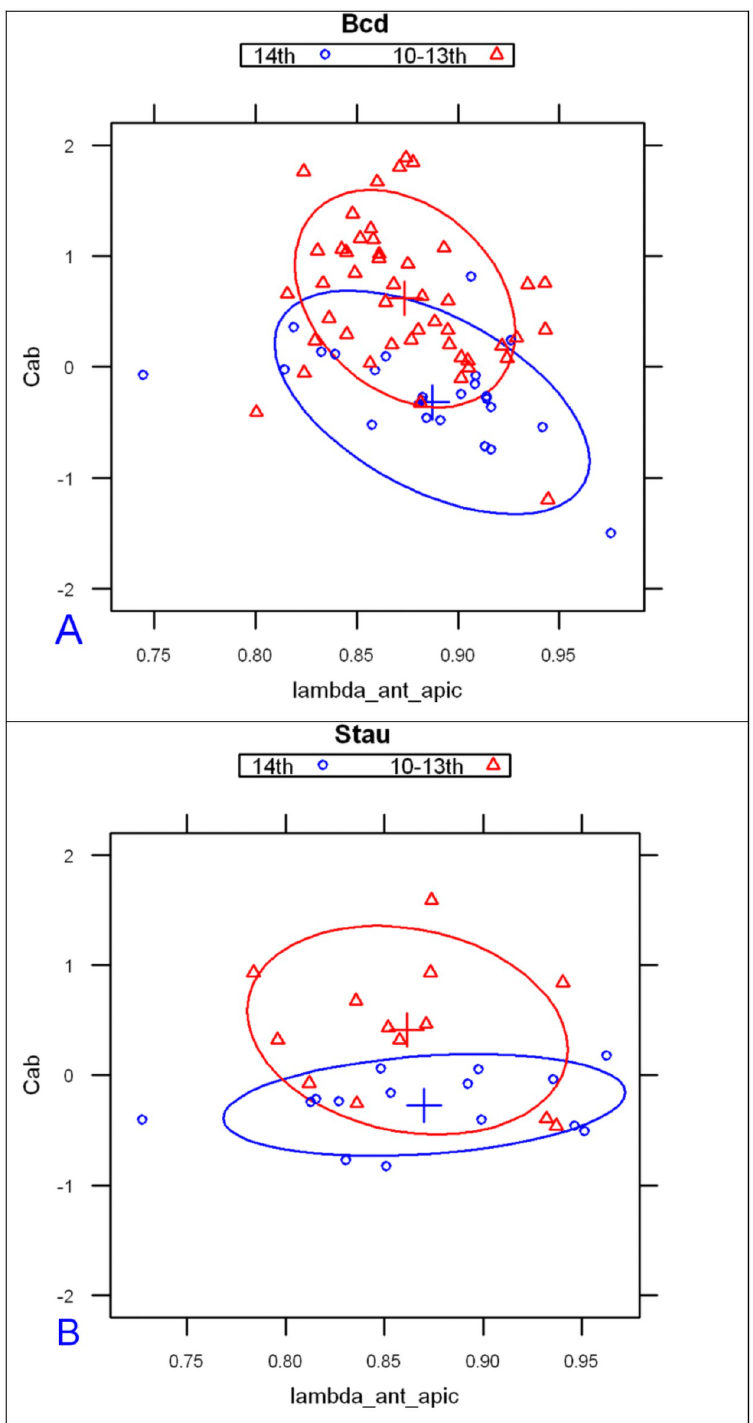
Fig 11. Apical intensities (C1 parameters) rise sharply from syncytial blastoderm (red) to cc14 (blue; cellularizing blastoderm). This is seen with both bcd mRNA (A) and Stau (B). This is a ‘flip’ from the decreasing apical intensity seen earlier, from the cleavage to syncytial blastoderm